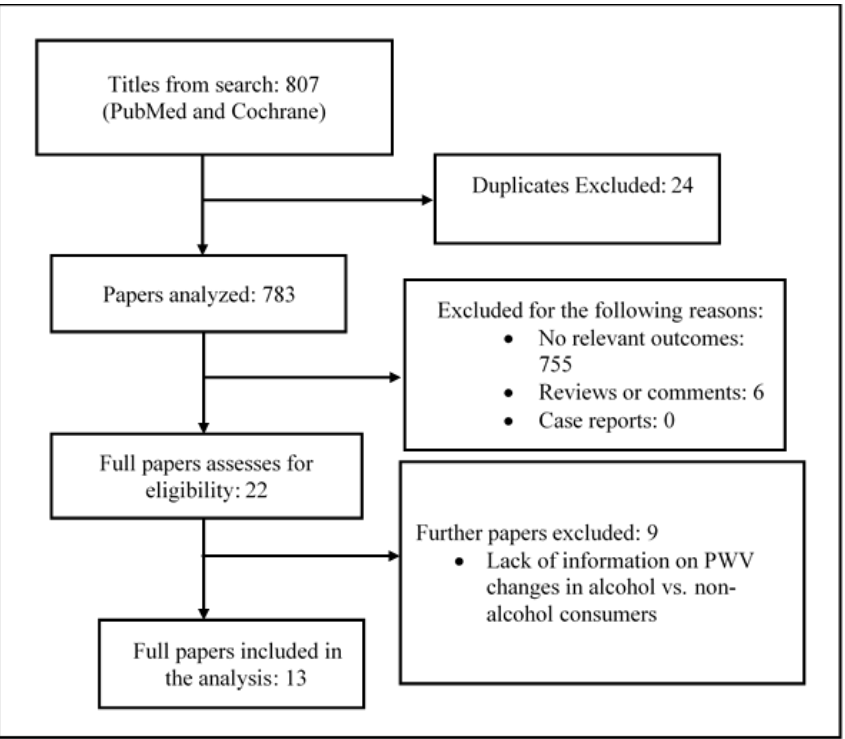
Figure 1. Flow chart of the study selection in the systematic review.